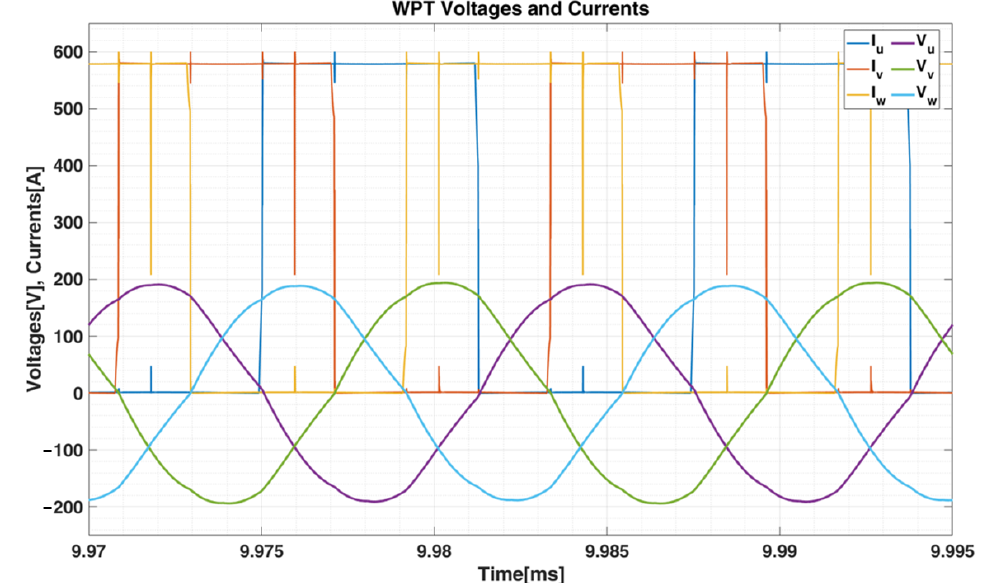
Figure 7. Simulated trends of currents and voltages at primary side of WPT